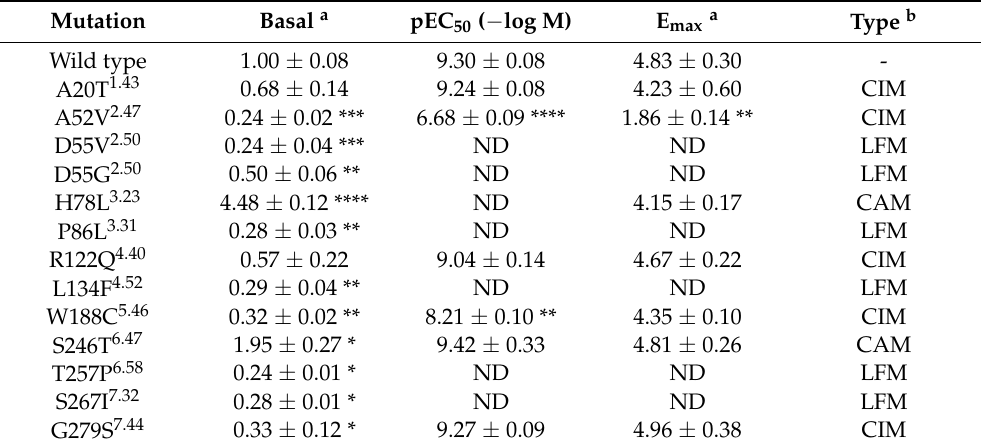
Figure 2. Concentration–response curves of wild type and mutated hA 1 ARs. Data are separated for mutations located on ( A ) the first and second transmembrane helix, ( B ) third and fourth transmem- brane helix, and ( C ) fifth, sixth, and seventh transmembrane helix. Data were normalized as ratio over basal activity of wild type hA 1 AR (dotted line). Combined graphs are shown as mean ± SEM from at least three individual experiments performed in duplicate. Data for wild type are shown in dark blue, for CIMs in red, for CAMs in green, and for LFMs in grey. Table 2. Agonist (CPA)-induced receptor activation of wild type and mutant hA 1 ARs in yeast liquid growth